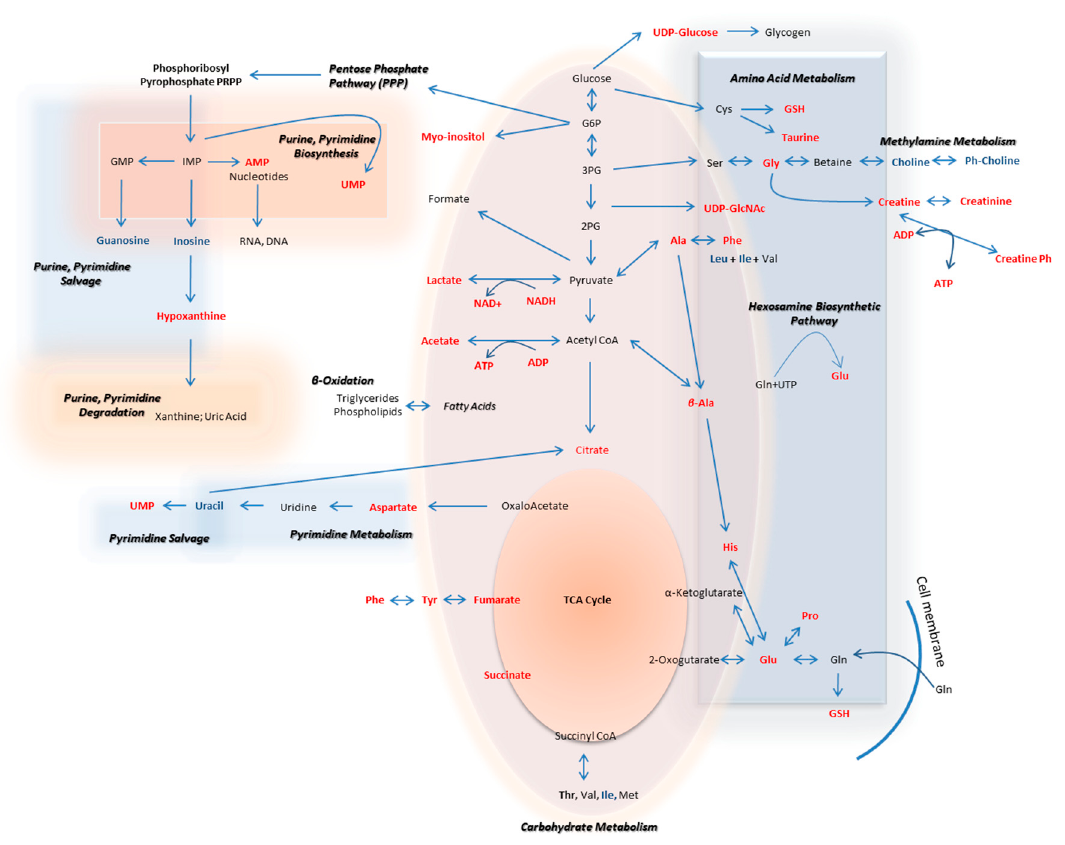
Figure 12. Flow-diagram showing pathways and cognate metabolites critically involved in the discrimination of primary and metastatic human melanoma cells. Blue: reduced levels (Fold Change < 0.50); Red: increased levels (Fold Change > 2). The metastatic cell group is presented with elevated